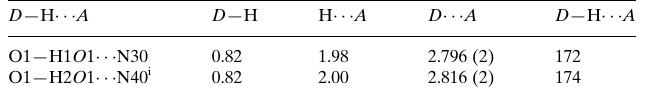
Hydrogen-bond geometry (A˚ , (cid:3)